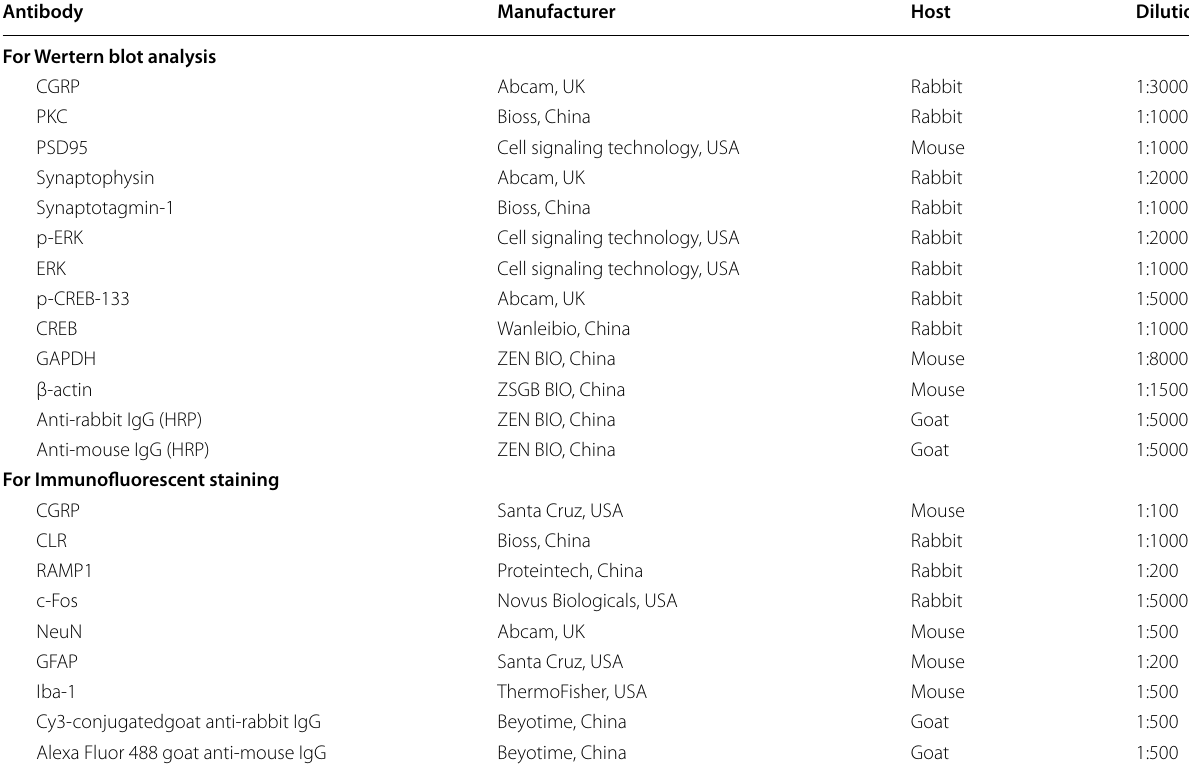
Table 1 Antibodies used in western blot and immunofluorescence staining analysis Antibody For Wertern blot